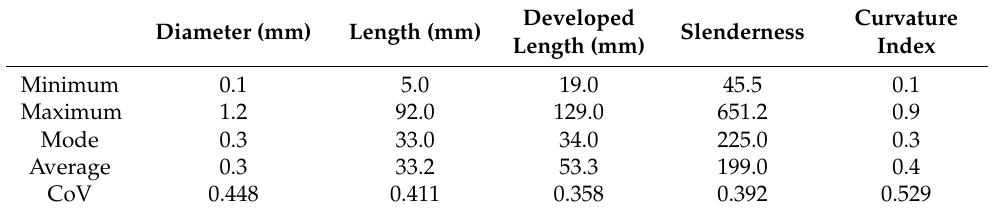
Table 4. Geometric properties of